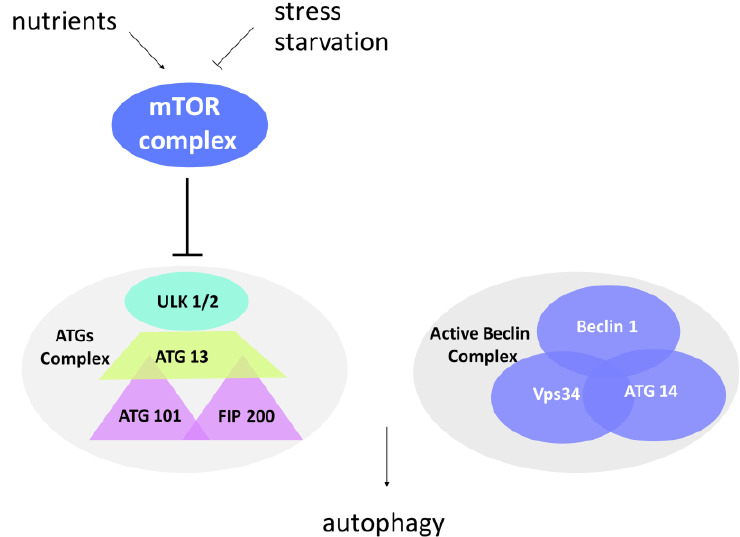
Figure 2. Protein complexes involved in autophagosome formation. Mammalian Target Of Rapamycin (mTOR) complex is an important sensor of stress and nutrient conditions in the cells. In response to nutrient availability, mTOR is activated, promotes cell growth, and blocks autophagy by inducing hyperphosphorylation of the ATG complex. In contrast to this, stress and starvation block the mTOR complex and induce the activation of autophagy. The ATG1 complex (uncoordinate-51-like kinase 1 (ULK1) in mammals) promotes the formation of PAS in the initiation step, while the Beclin-1 complex mediates the recruitment of ATG proteins to the phagophore in order to induce its elongation and maturation.